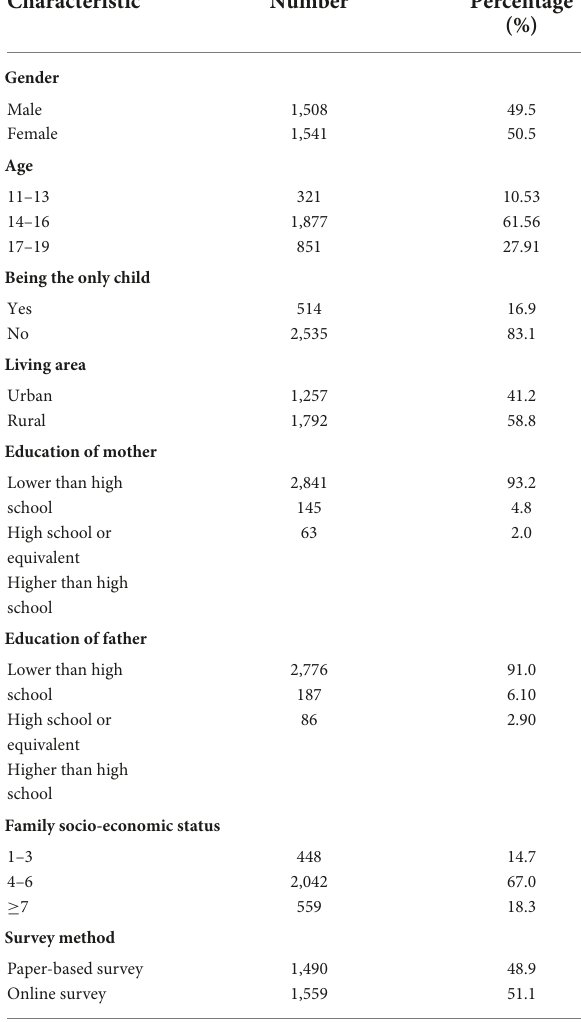
TABLE 1 Socio-demographic characteristics of junior and senior high school